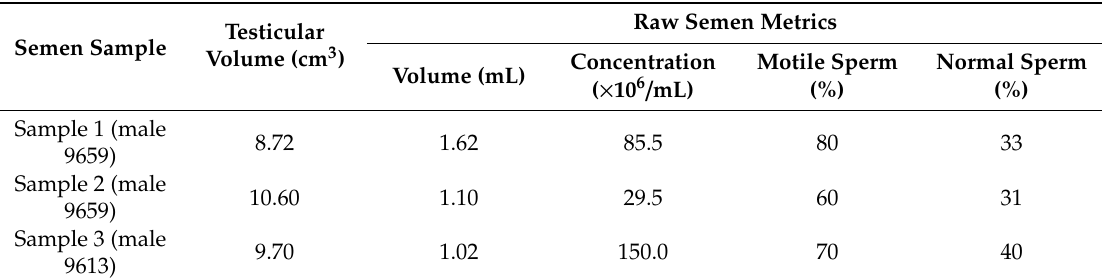
Table 1. Testicular and raw semen metrics of male